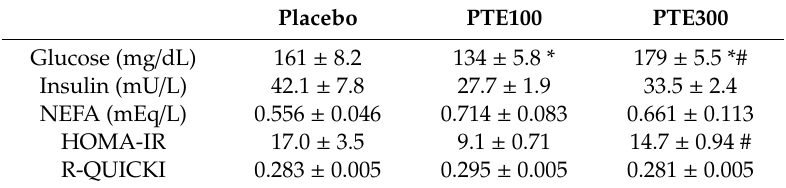
Table 2. Plasma analyses and insulin resistance / sensitivity indexes in animals. Placebo PTE100 PTE300 Glucose (mg / dL) 161 ±